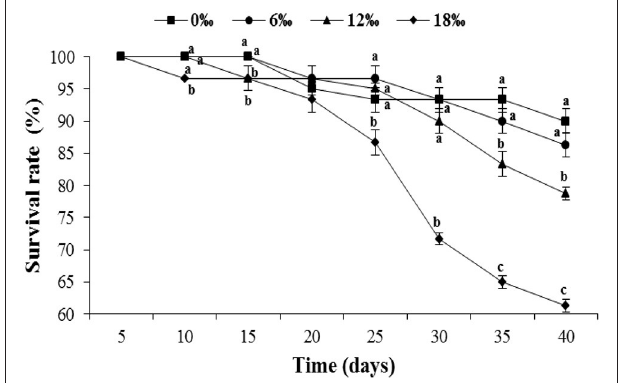
FIGURE 1 | The survival rate (%) ( ± SE) of the female Eriocheir sinensis subjected to different salinities for 40 days. Different letters on the top of different tag types in the same column indicated significant